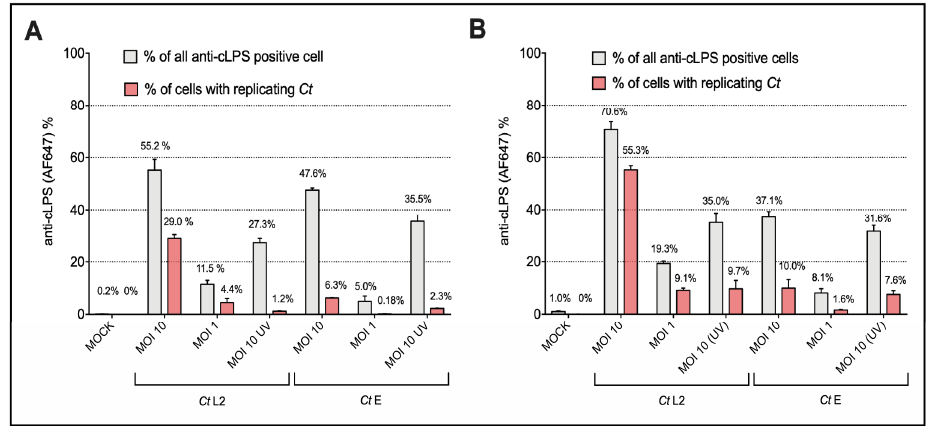
Figure 4. Flow cytometric analysis of anti-cLPS positive ( A ) THP-1 TLR4/CD14/MD2 and ( B ) Jurkat TLR4/CD14/MD2 reporter cells. The cells were incubated for 40 h with Ct preparations of serovar L2 ( Ct L2) or serovar E ( Ct E). The preparations included viable bacteria (MOI 10, MOI 1) as well as UV- [(MOI 10 (UV)] Ct . Mock controls are shown on the left. The grey bars indicate percentages of cLPS positive cells in the upper two contour plot quadrants of the flow cytometry plots. The red bars represent percentages of cells localized in the red gate that contain with high probability replicating Ct . The flow cytometry plots of one representative experiment are shown in Figure S4. The data represent percentage means (numbers shown) ± SEM of three independent experiments.